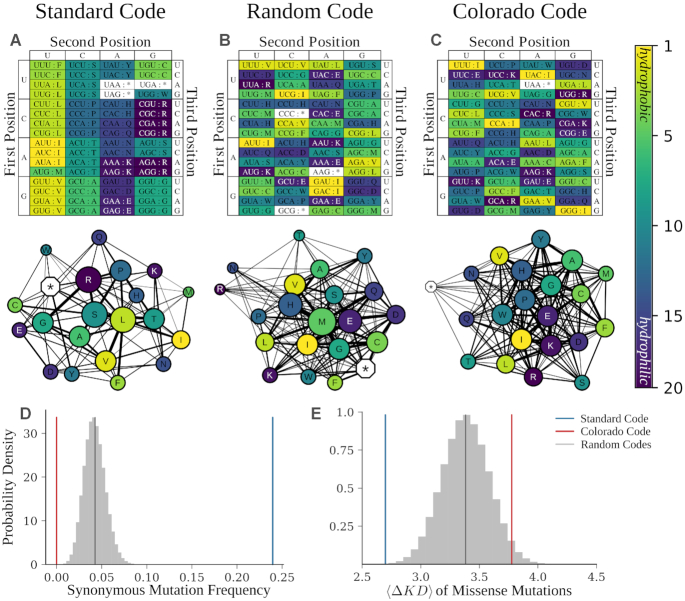
Genetic codes are expected to influence evolutionary dynamics. Table and mutation-distance network representations for the (A) Standard Code, (B) a genetic code with random structure, (C) and the Colorado Code. Color signifies the rank-ordered hydropathy of the amino acids—isoleucine (I) is most hydrophobic and arginine (R) is most hydrophilic. Mutation-distance networks represent amino acids as nodes. Node size represents the number of codons allocated to each amino acid or null. Edge weights between nodes (representing amino acids \documentclass[12pt]{minimal}
\usepackage{amsmath}
\usepackage{wasysym}
\usepackage{amsfonts}
\usepackage{amssymb}
\usepackage{amsbsy}
\usepackage{upgreek}
\usepackage{mathrsfs}
\setlength{\oddsidemargin}{-69pt}
\begin{document}
}{}${{\rm{a}}_1}$\end{document} and \documentclass[12pt]{minimal}
\usepackage{amsmath}
\usepackage{wasysym}
\usepackage{amsfonts}
\usepackage{amssymb}
\usepackage{amsbsy}
\usepackage{upgreek}
\usepackage{mathrsfs}
\setlength{\oddsidemargin}{-69pt}
\begin{document}
}{}${{\rm{a}}_2}$\end{document}) represent the accessibility of \documentclass[12pt]{minimal}
\usepackage{amsmath}
\usepackage{wasysym}
\usepackage{amsfonts}
\usepackage{amssymb}
\usepackage{amsbsy}
\usepackage{upgreek}
\usepackage{mathrsfs}
\setlength{\oddsidemargin}{-69pt}
\begin{document}
}{}${{\rm{a}}_2}$\end{document} to \documentclass[12pt]{minimal}
\usepackage{amsmath}
\usepackage{wasysym}
\usepackage{amsfonts}
\usepackage{amssymb}
\usepackage{amsbsy}
\usepackage{upgreek}
\usepackage{mathrsfs}
\setlength{\oddsidemargin}{-69pt}
\begin{document}
}{}${{\rm{a}}_1}$\end{document} via point mutations. (D) Distribution of synonymous-mutation frequency (\documentclass[12pt]{minimal}
\usepackage{amsmath}
\usepackage{wasysym}
\usepackage{amsfonts}
\usepackage{amssymb}
\usepackage{amsbsy}
\usepackage{upgreek}
\usepackage{mathrsfs}
\setlength{\oddsidemargin}{-69pt}
\begin{document}
}{}${{\rm{f}}_{\rm{s}}}$\end{document}) for \documentclass[12pt]{minimal}
\usepackage{amsmath}
\usepackage{wasysym}
\usepackage{amsfonts}
\usepackage{amssymb}
\usepackage{amsbsy}
\usepackage{upgreek}
\usepackage{mathrsfs}
\setlength{\oddsidemargin}{-69pt}
\begin{document}
}{}${10^6}$\end{document} randomly generated codes (gray histogram) and mean of this distribution (black), as well as \documentclass[12pt]{minimal}
\usepackage{amsmath}
\usepackage{wasysym}
\usepackage{amsfonts}
\usepackage{amssymb}
\usepackage{amsbsy}
\usepackage{upgreek}
\usepackage{mathrsfs}
\setlength{\oddsidemargin}{-69pt}
\begin{document}
}{}${{\rm{f}}_{\rm{s}}}$\end{document} for the Standard Code (blue) and Colorado Code (red). (E) Distribution of mean mutation effects given a nonsynonymous mutation, (\documentclass[12pt]{minimal}
\usepackage{amsmath}
\usepackage{wasysym}
\usepackage{amsfonts}
\usepackage{amssymb}
\usepackage{amsbsy}
\usepackage{upgreek}
\usepackage{mathrsfs}
\setlength{\oddsidemargin}{-69pt}
\begin{document}
}{}$\langle {\rm{\Delta KD}}\rangle$\end{document}), for \documentclass[12pt]{minimal}
\usepackage{amsmath}
\usepackage{wasysym}
\usepackage{amsfonts}
\usepackage{amssymb}
\usepackage{amsbsy}
\usepackage{upgreek}
\usepackage{mathrsfs}
\setlength{\oddsidemargin}{-69pt}
\begin{document}
}{}${10^6}$\end{document} randomly generated codes (gray histogram) and mean of this distribution (black), as well as \documentclass[12pt]{minimal}
\usepackage{amsmath}
\usepackage{wasysym}
\usepackage{amsfonts}
\usepackage{amssymb}
\usepackage{amsbsy}
\usepackage{upgreek}
\usepackage{mathrsfs}
\setlength{\oddsidemargin}{-69pt}
\begin{document}
}{}${\rm{\Delta KD}}$\end{document} for the Standard Code (blue) and Colorado Code (red). We defined \documentclass[12pt]{minimal}
\usepackage{amsmath}
\usepackage{wasysym}
\usepackage{amsfonts}
\usepackage{amssymb}
\usepackage{amsbsy}
\usepackage{upgreek}
\usepackage{mathrsfs}
\setlength{\oddsidemargin}{-69pt}
\begin{document}
}{}$\langle {\rm{\Delta KD}}\rangle$\end{document} of a genetic code as the average over all nonsynonymous mutations (from \documentclass[12pt]{minimal}
\usepackage{amsmath}
\usepackage{wasysym}
\usepackage{amsfonts}
\usepackage{amssymb}
\usepackage{amsbsy}
\usepackage{upgreek}
\usepackage{mathrsfs}
\setlength{\oddsidemargin}{-69pt}
\begin{document}
}{}${{\rm{a}}_1}$\end{document} to \documentclass[12pt]{minimal}
\usepackage{amsmath}
\usepackage{wasysym}
\usepackage{amsfonts}
\usepackage{amssymb}
\usepackage{amsbsy}
\usepackage{upgreek}
\usepackage{mathrsfs}
\setlength{\oddsidemargin}{-69pt}
\begin{document}
}{}${{\rm{a}}_2}$\end{document}) of the change in Kyte–Doolittle hydropathy (\documentclass[12pt]{minimal}
\usepackage{amsmath}
\usepackage{wasysym}
\usepackage{amsfonts}
\usepackage{amssymb}
\usepackage{amsbsy}
\usepackage{upgreek}
\usepackage{mathrsfs}
\setlength{\oddsidemargin}{-69pt}
\begin{document}
}{}${\rm{\Delta KD}}$\end{document}) between the two residues (\documentclass[12pt]{minimal}
\usepackage{amsmath}
\usepackage{wasysym}
\usepackage{amsfonts}
\usepackage{amssymb}
\usepackage{amsbsy}
\usepackage{upgreek}
\usepackage{mathrsfs}
\setlength{\oddsidemargin}{-69pt}
\begin{document}
}{}${\rm{\Delta KD\ }} = {\rm{\ }}| {{\rm{\ KD}}( {{{\rm{a}}_2}} ) - {\rm{KD}}( {{{\rm{a}}_1}} )} |$\end{document}).